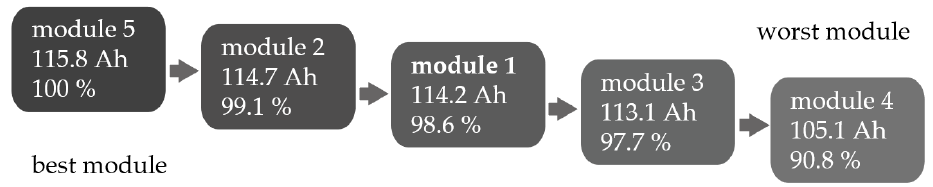
Figure 12. Evaluation of the capacity of the battery modules from Step 3 of the test procedure.